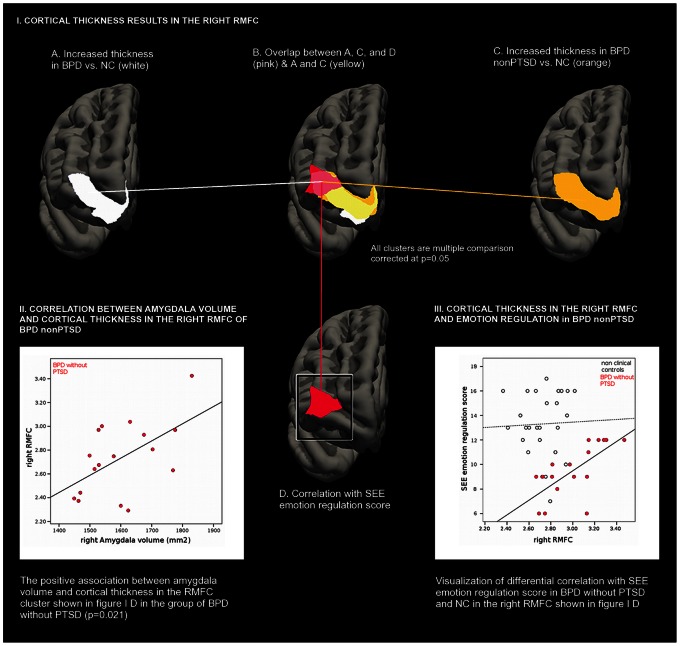
Summary of results.